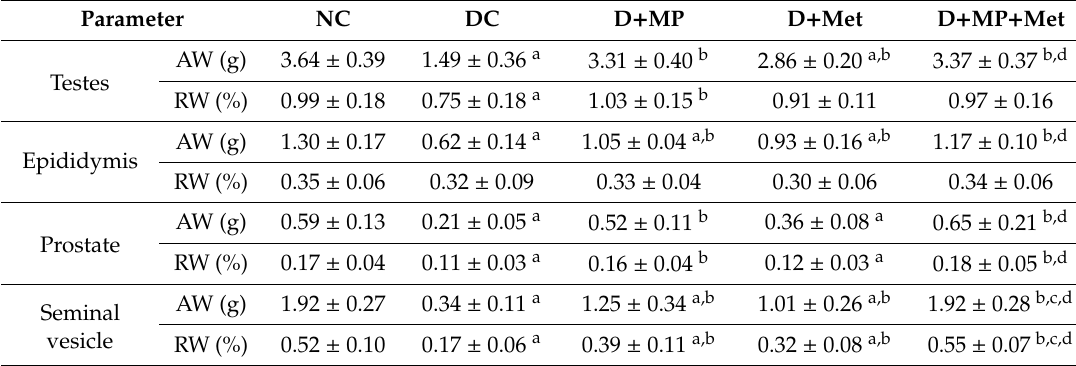
Table 1. Weights and relative weights of reproductive organs in all experimental